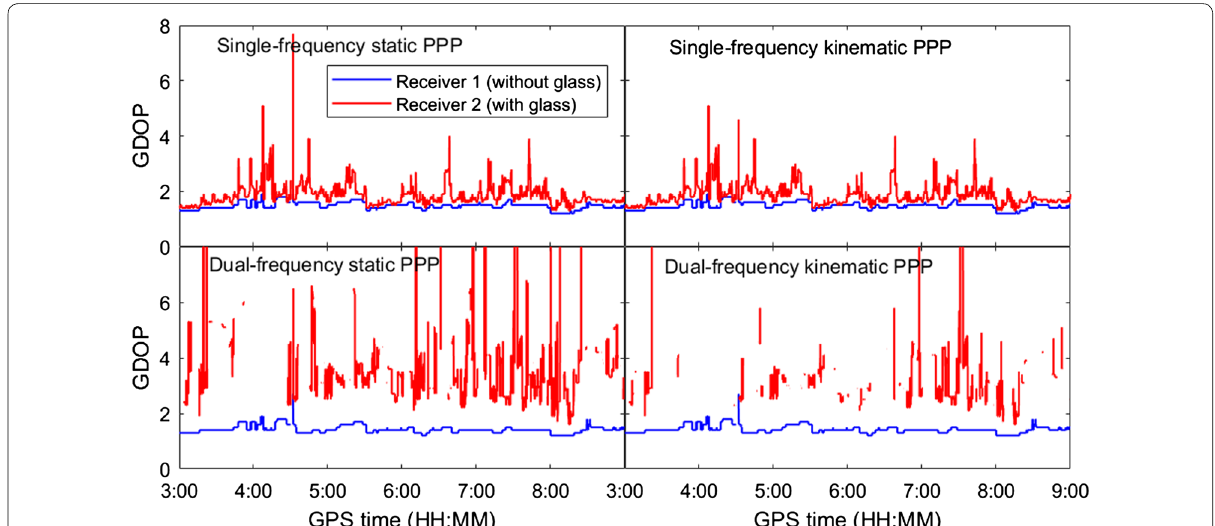
Fig. 8 GDOP of receiver 1 (without HST window glass, blue line) and receiver 2 (with HST window glass, red line) in different GPS/GLONASS PPP modes during period